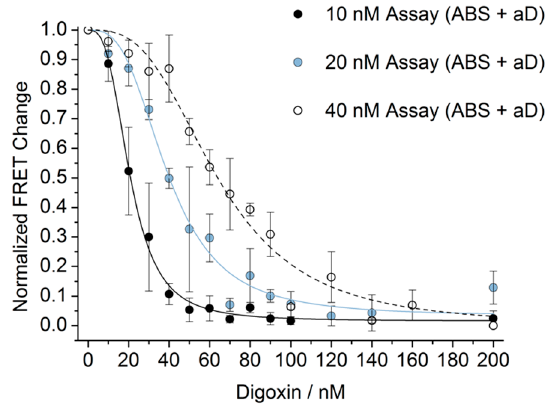
Figure 8. A three-assay setup. Normalized FRET change for three different SDC assay concentrations